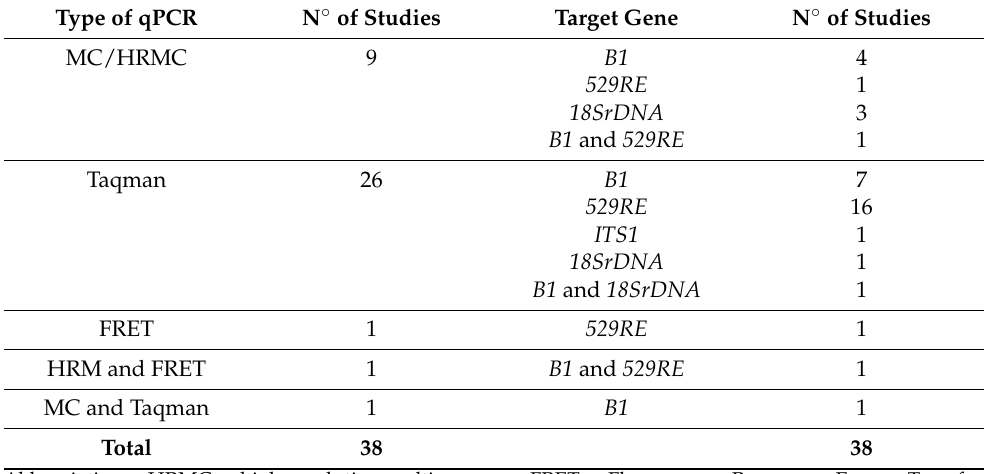
Table 5. qPCR-based assay and targets used for Toxoplasma gondii oocyst detection in reviewed literature.